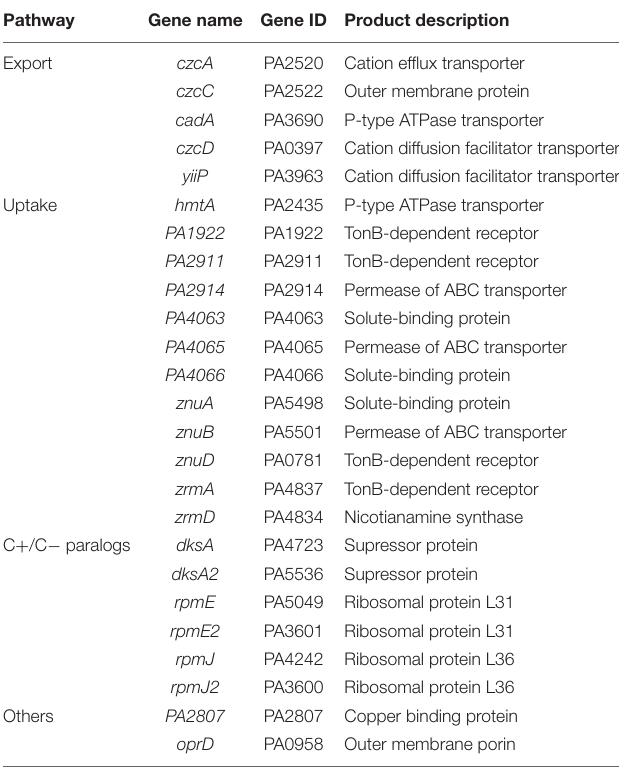
TABLE 1 | List of the twenty-five genes monitored for zinc homeostasis analysis.